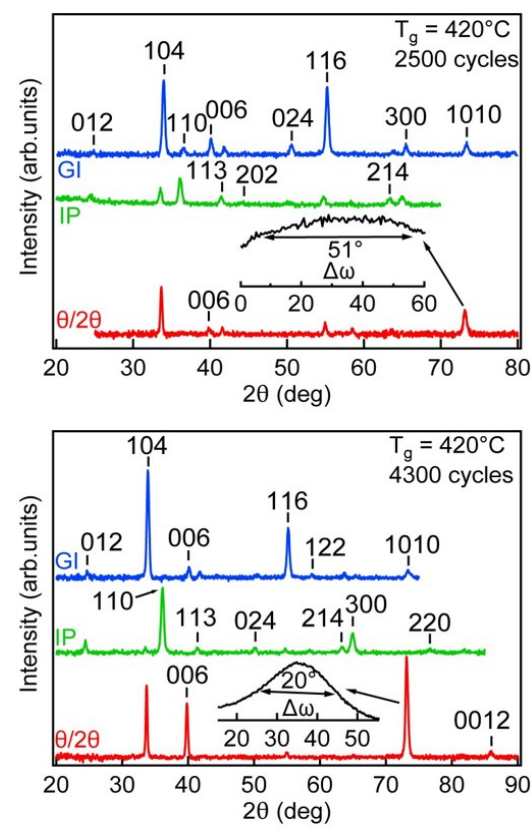
Figure 3. XRD patterns recorded in grazing incidence (GI), in-plane (IP) and symmetrical ( Θ /2 Θ ) setup for film grown at 420 ◦ C with 2500 and 4300 cycles. The inset above the Θ /2 Θ -XRD pat- tern presents rocking curve ( ω -scan) of 1010 reflection showing FWHM of approximately 51 ◦ for 2500 cycles and 20 ◦ for 4300